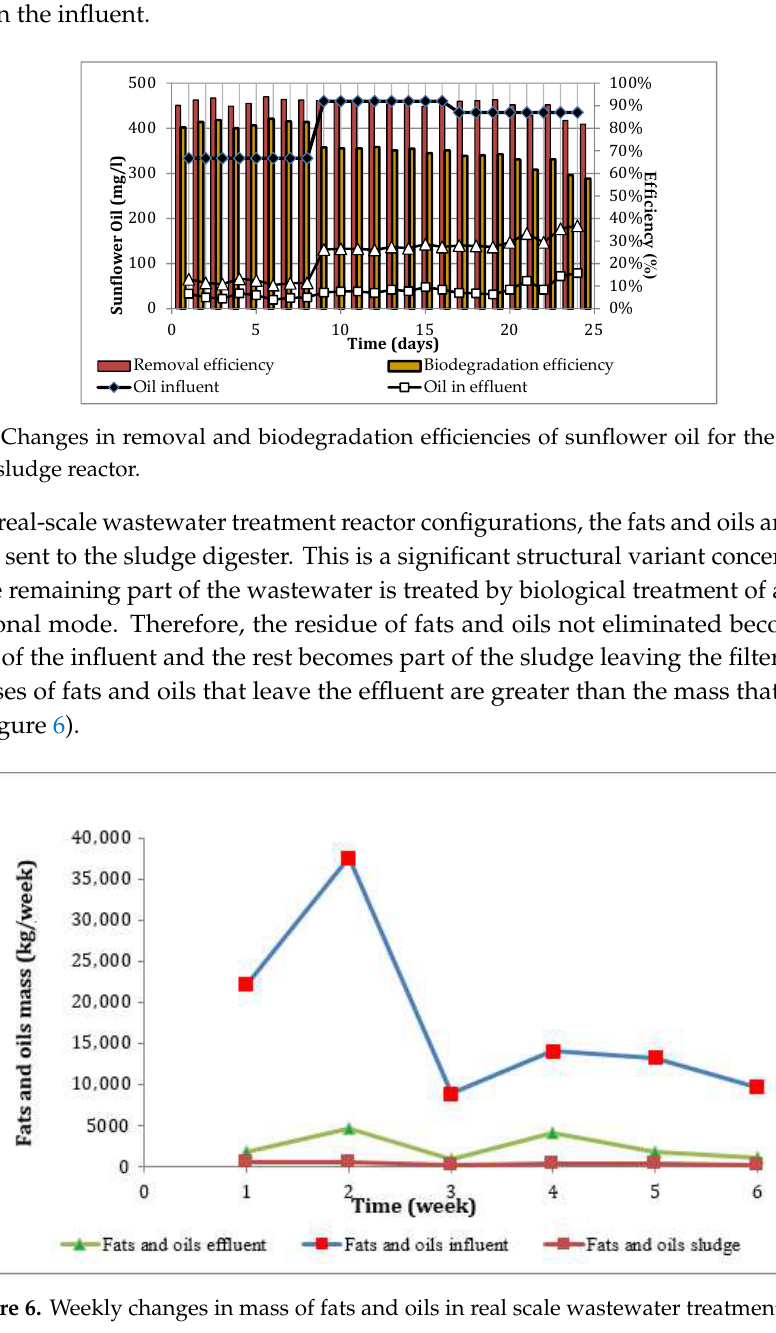
Figure 4. General flow diagram of the Los Angeles WWTP.